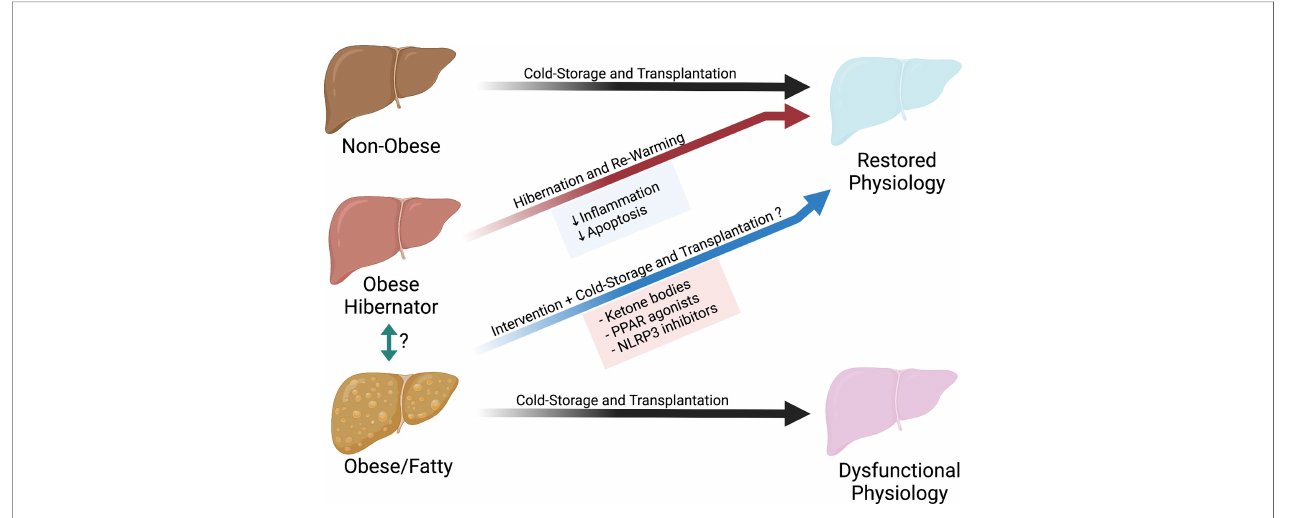
FIGURE 2 | Potential pathway to restore organs from obese